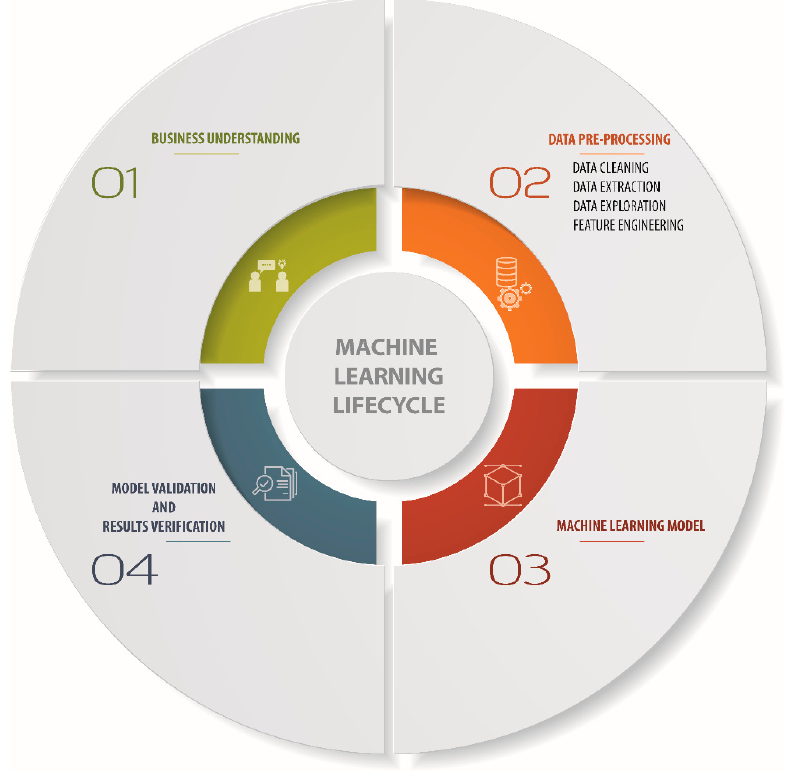
Figure 5. Machine learning lifecycle.